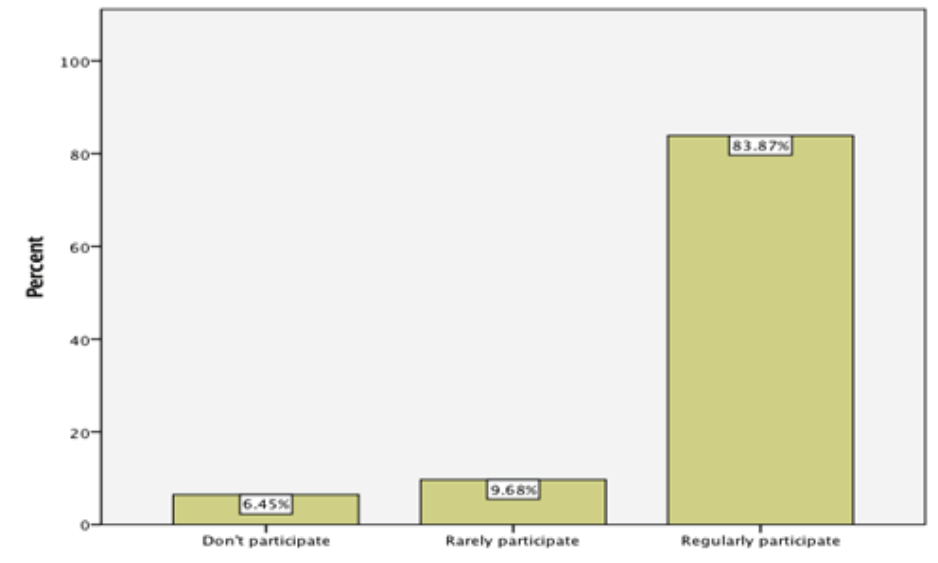
Figure 4: Characterization of staff’s participation in the FPD in